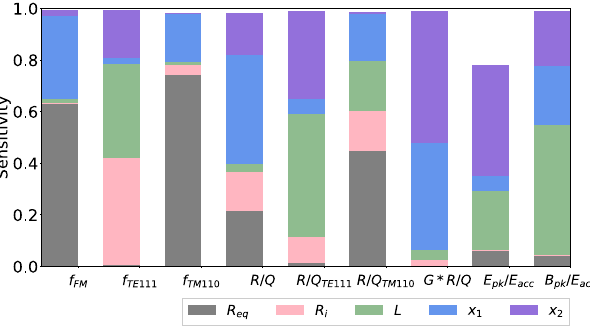
FIG. 14. Main sensitivities. The intervals for the geometric parameters R eq , R i , L , x 1 , and x 2 [cf. Fig. 12] are given in Table VII. The polynomial degree is p ¼ 2 , so the size of the sample is 84 [cf. Table I].